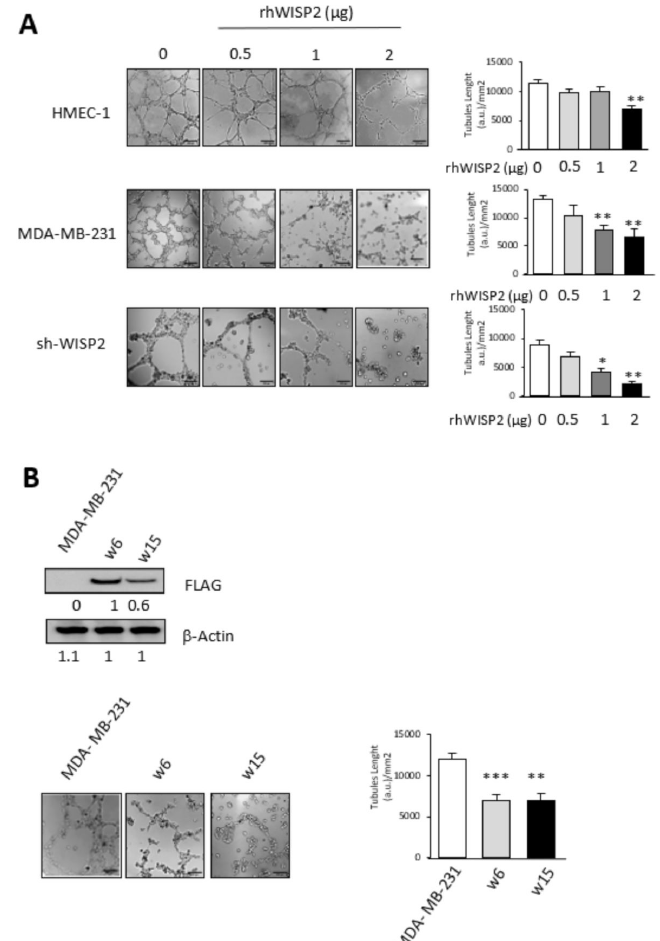
Figure 3. WISP2 inhibits VM tubes formation ( A ) HMEC-1 endothelial cells, and breast cancer MDA- MB- 231 and sh-WISP2 cells were pre-treated for 48 h with 0.5, 1, and 2 µ g of human recombinant WISP2 (rhWISP2) before being seeded on Matrigel. Representative images of VM were observed over 24 h, and length of tubes quantified. ( B ) Western Blot showing overexpression of WISP2 in two clones (w6 and w15) of MDA-MB-231 stably transfected with Flag-WISP2 expressing vector. Representative images and quantitation of length of tubes formation in w6 and w15 cell lines. Levels of proteins were calculated by densitometry and listed beneath the bands. Scale bar = 200 µ m. * p < 0.05; ** p < 0.01; *** p < 0.005. The original western blots can be found in File